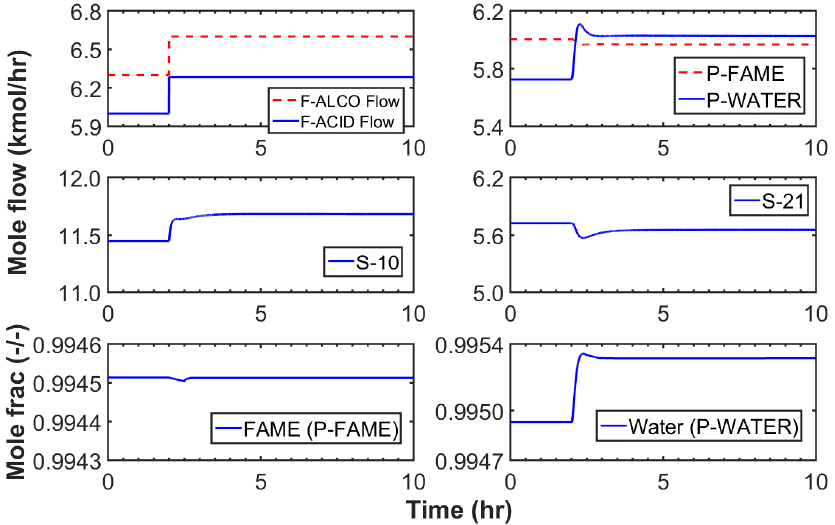
Figure 13. Stream results with cascade control scheme when the methanol feed flow was changed by +5%.